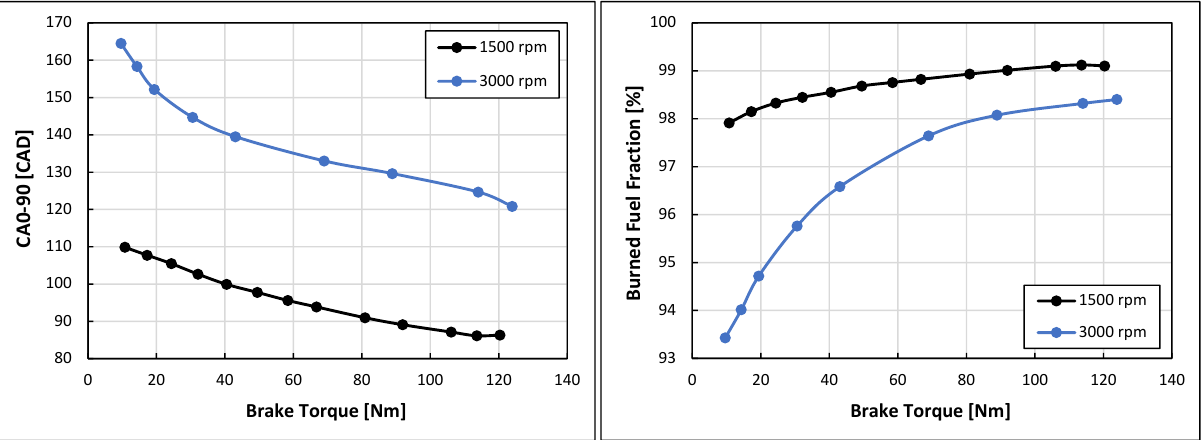
Figure 16. CA0-90 ( left ) and burned fuel fraction ( right ) vs. engine torque for both 1500 and 3000 rpm operating points. ϕ = 1, no boost.